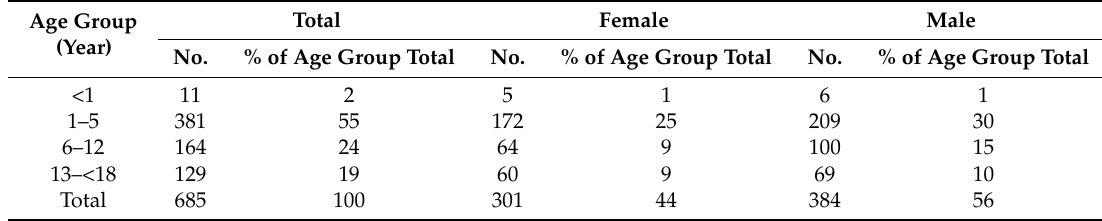
Table 1. Distribution of events in childhood reported by age group and gender.